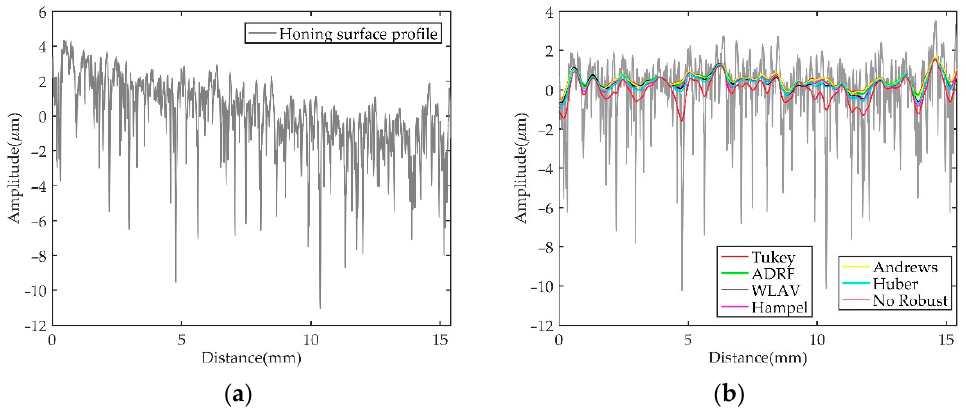
Figure 11. ( a ) Honing profile and ( b ) waviness profile after using the robust filter.